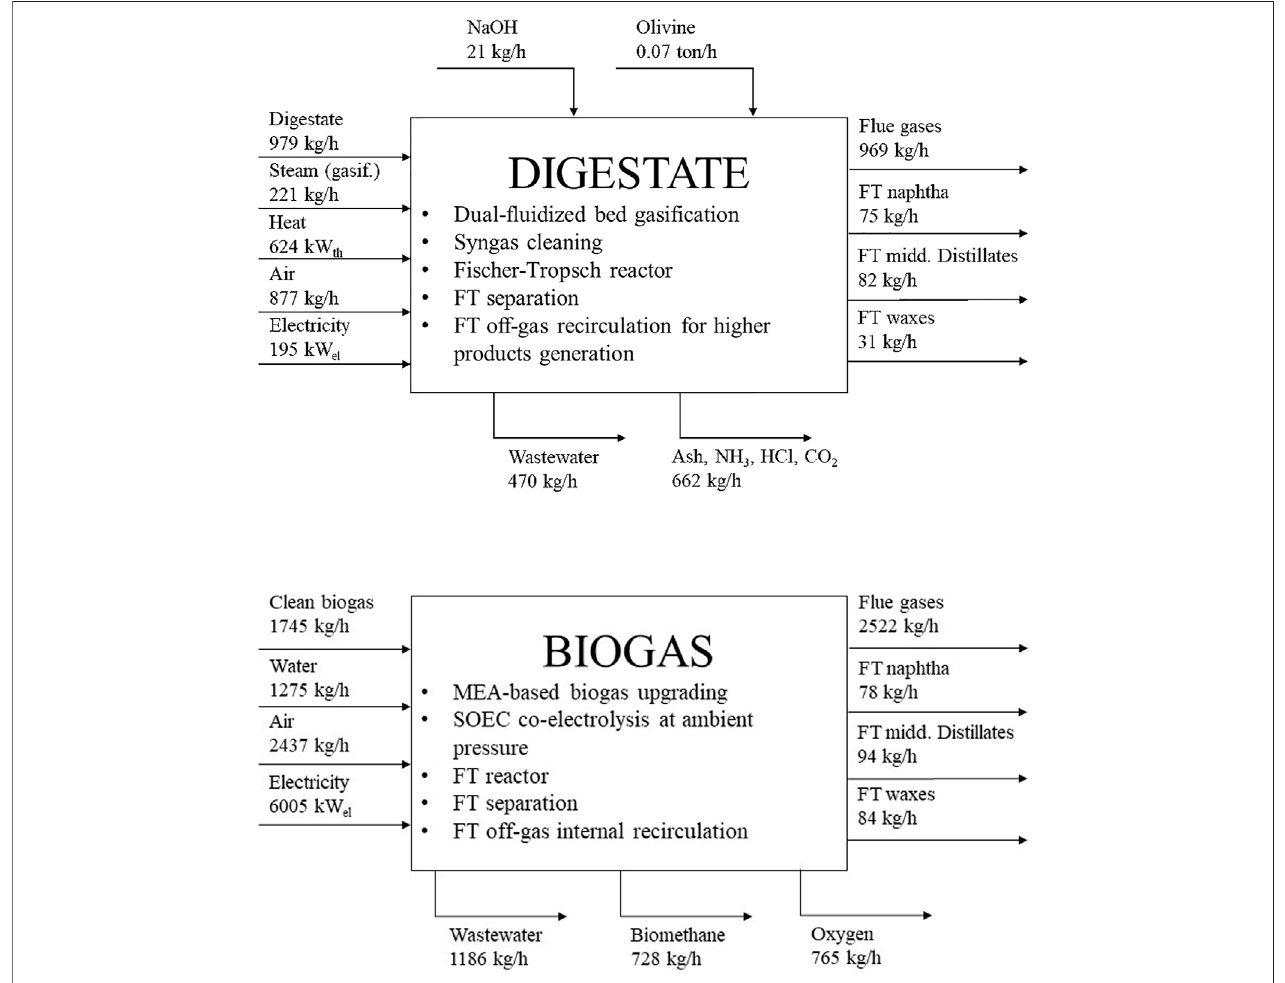
FIGURE 4 | Schematics of the process routes taken as a baseline reference for the evaluation of the Fischer – Tropsch production potential, with information about the main process technologies involved in the route. Adapted from (Marchese et al., 2020; Marchese et al., 2021b; Marchese, 2021).